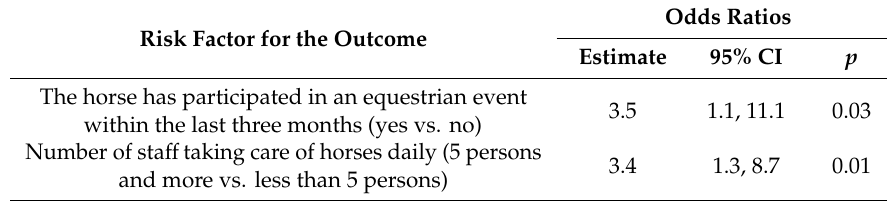
Table 3. Parameter estimates and odds ratios from a multivariable regression modeling MDR positive status at the horse level, based on the results of a cross-sectional study performed on 32 premises and 209 healthy adult horses, sampled in Quebec, in summers 2015 and 2016. The estimated variance at the premises level was 0.171 (standard error of